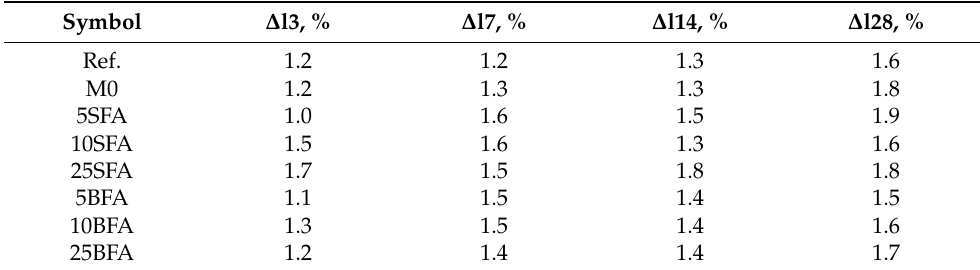
Table 6. Elongation at break of tested mortars.